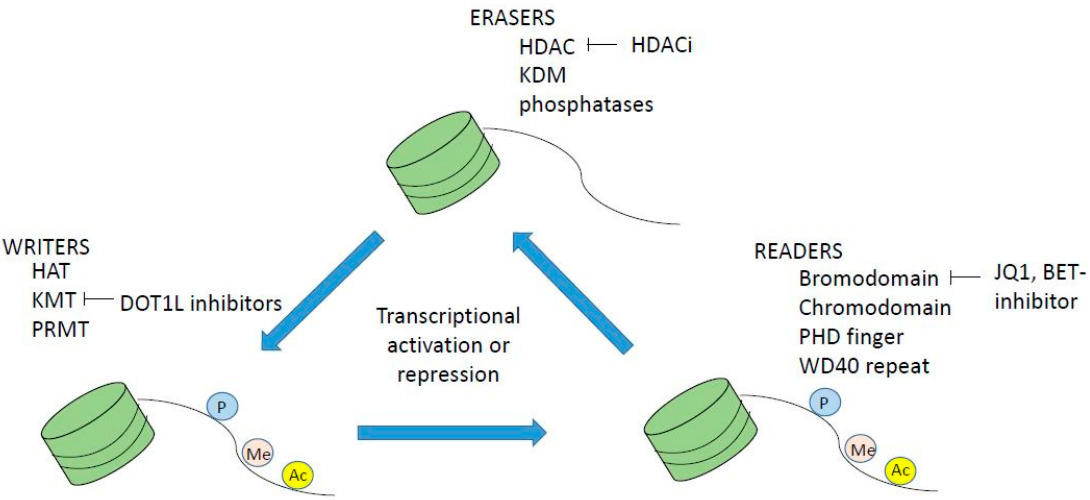
Figure 3. Epigenetic writers are histone acetyl transferases HAT (KAT), histone lysine methyl transferase (KMT) and PRMTs (protein arginine methyl transferases), readers are bromodomain proteins like BET family proteins, and erasers are histone deacetylase inhibitors (HDACi), KDM (lysine/histone demethylases) and phosphatases. Inhibitors or writers, readers and erasers are being developed and are in clinical trials for myeloid malignancies, for example HDACi, bromodomain BET inhibitor Q1 and DOT1L inhibitors, of which the latter are in clinical phase I trials.